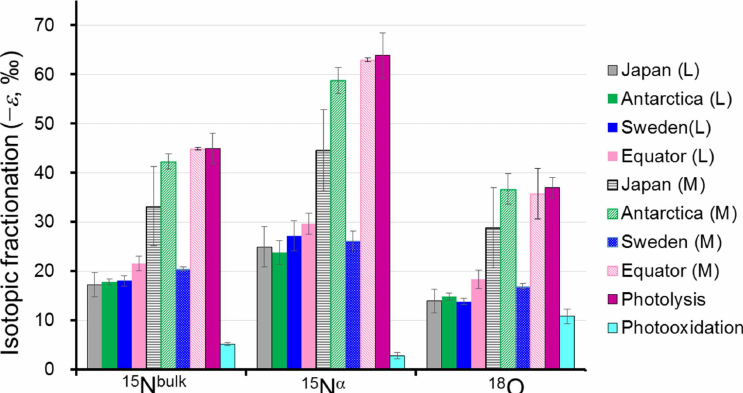
Figure 4. Comparison of absolute values of the isotopocule fractionation ( | ε | ) for 15 N bulk , 15 N α , and 18 O of N 2 O between observa- tions and laboratory experiments. L and M respectively refer to the lower and middle stratosphere with boundary mixing ratio of about 170nmolmol − 1 ( − ln {[ N 2 O ] / [ N 2 O] 0 } = 0.6) and 260nmolmol − 1 ( − ln {[ N 2 O ] / [ N 2 O] 0 } = 0.2) for extratropics and tropics, respectively, based on the Rayleigh plot shape (Fig. 3). The respective | ε | for Japan, Sweden, and Antarctica are from Toyoda et al. (2004). Those for pho- tolysis and photooxidation experiments are referred from reports by Kaiser et al. (2002a, b, 2003) and Toyoda et al. (2004). Error bars show either the standard deviation for the mean value (observation over Japan and photooxidation experiments), standard error associated with linear regression in Rayleigh plot (observations except Japan), or the possible range for stratospheric conditions (photolysis